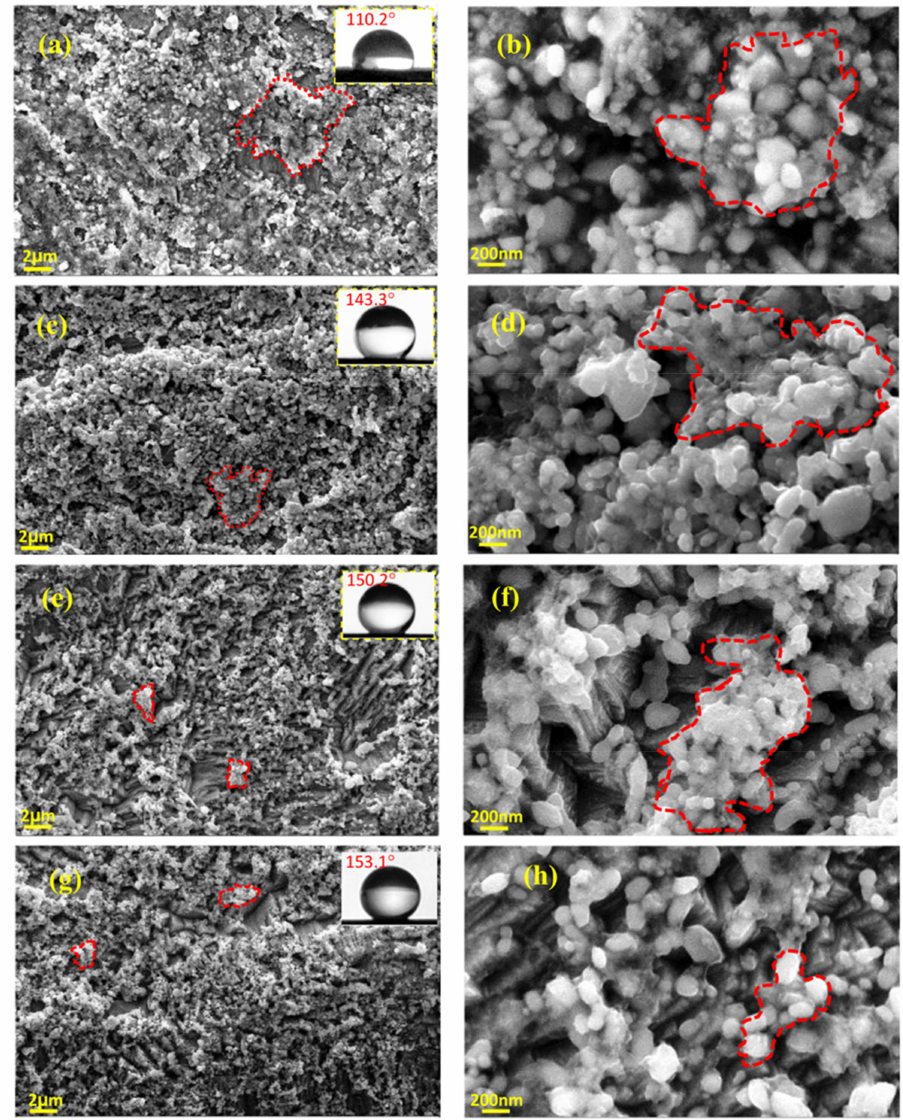
Figure 10. Scanning electron microscopy of electrodeposited coatings; ( a , b ) boric-free direct electrodeposition; ( c , d ) boric-assisted direct electrodeposition; ( e , f ) boric-free pulsed electrodeposition; and, ( g , h ) boric-assisted